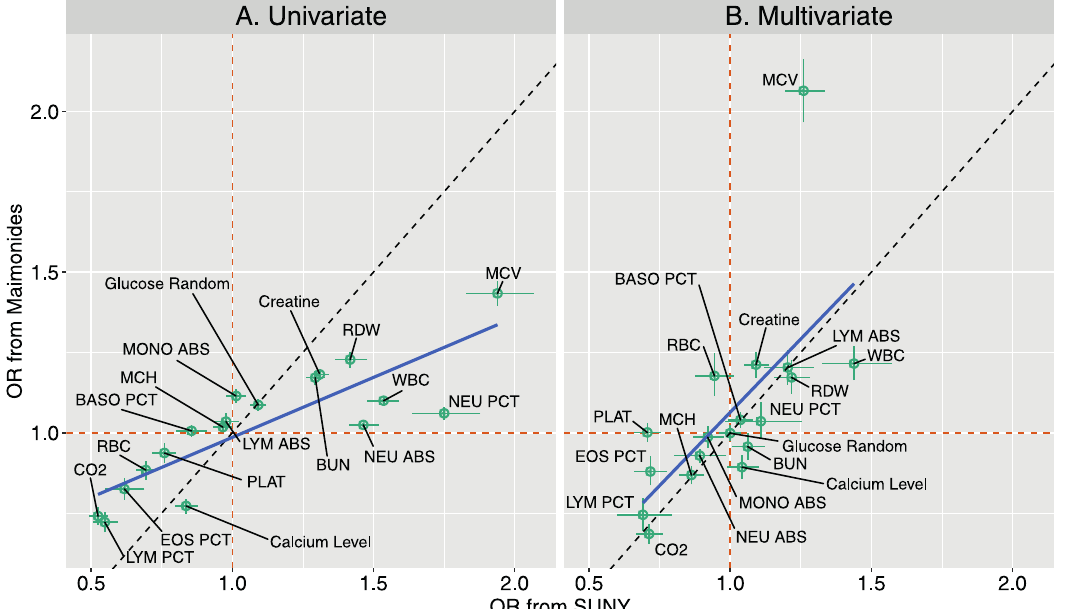
Fig 4. Comparing ORs for dynamic laboratory measurements. Panels A/B compare the ORs for the univariate/multivariate models. The horizontal axes displays the ORs for daily mortality risk from SUNY and the vertical axes show the ORs from Maimonides. Points show the posterior median ORs; the whiskers display the 25% and 75% posterior quantiles. The orange dashed lines show the OR = 1 cases; the dashed black lines indicate equality across ORs calculated across the hospitals. The blue line shows least squares regression lines using the posterior median